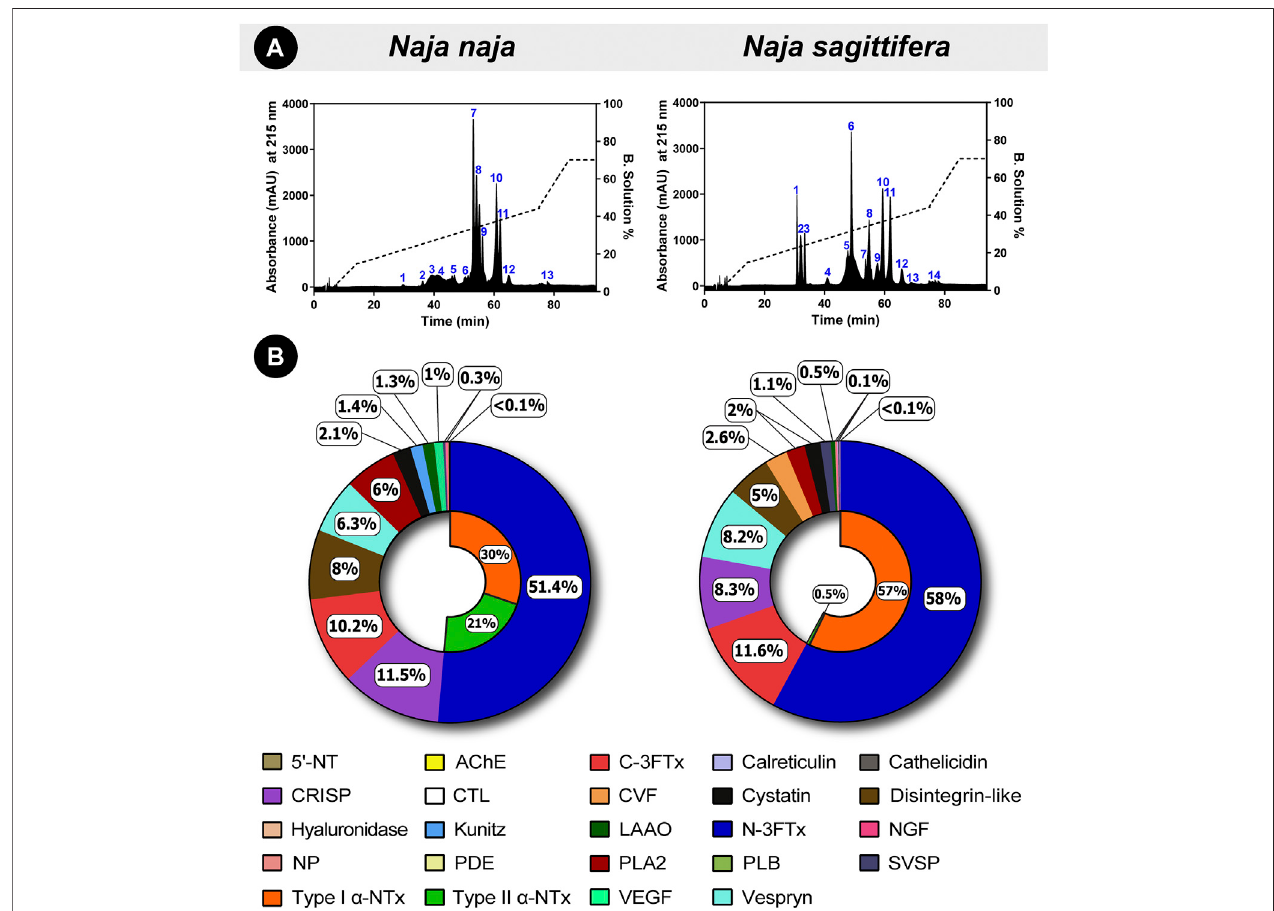
FIGURE3| Comparativevenomproteomicsof N.naja and N.sagittifera. Inthis fi gure, (A) RP-HPLCpro fi lesand (B) venomproteomesof Naja speciesareshown. Uniquely colour-coded individual fractions in RP-HPLC pro fi les are numbered from 1 – 14, whereas the relative abundance of each toxin family is indicated in the doughnut charts as percentages. The relative abundance of N-3FTx and C-3FTx in the two venoms has also been shown.